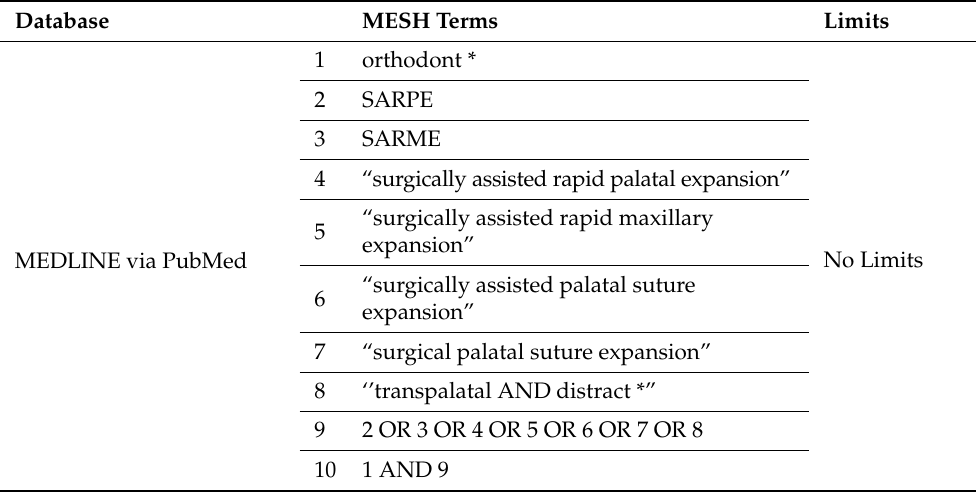
Table 1. Search strategy. * replaces one or more characters at the end of the search term.